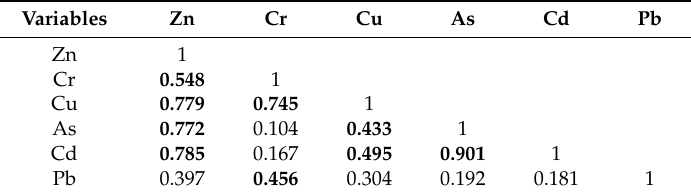
Table 6. Correlation of analyzed metals in river sediments.